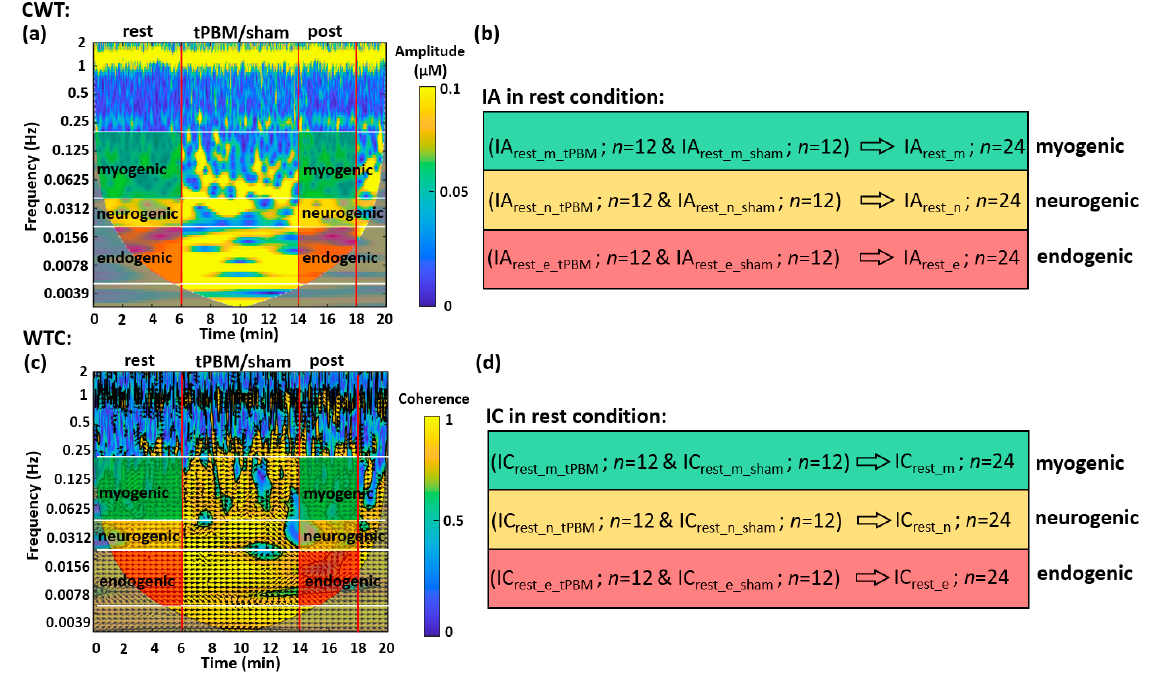
Figure 6. Example of CWT and WTC spectrograms presented in time-frequency maps and parame- terized indexes for the data taken at rest. ( a ) It plots a CWT spectrogram generated from the right forehead of one subject. The vertical red lines segment the experimental time into three periods: a 6-min resting period, an 8-min tPBM period, and a 4-min post-tPBM/sham period. The white hori- zontal lines mark three frequency bands: endogenic (0.005–0.02 Hz; red-shaded), neurogenic (0.02–0.04 Hz; yellow-shaded), and myogenic (0.04–0.2 Hz; green-shaded) bands. The colormap indicates the time-frequency dependent amplitude of wavelet transform of the Δ [HbO] time series. Two gray- shaded areas indicate the cone of influence (COI) caused by the edge effects of wavelets and ex- cluded for further data processing due to unreliability [84–86] . ( b ) It expresses the index of ampli- tude (IA) calculated by averaging CWT amplitude in the 2-dimensional, shaded areas given in ( a ) for respective ISO frequency bands. Subscripts of “rest_m_tPBM” and “rest_m_sham” mean under resting and sham conditions for tPBM experiment at myogenic frequency, respectively. The same notations apply to the other two situations. “ n = 12” indicates the subject number for each of tPBM and sham experiments. For both baseline measurements, the total measurement number becomes 24. ( c ) It plots a WTC spectrogram generated from the coherence between two bilateral Δ [HbO] time series of one subject. Both red vertical and white horizontal lines serve the same purposes as those in ( a ). The arrows indicate the phase relationships between the two time series. The colormap marks time-frequency-dependent coherence amplitude between two bilateral Δ [HbO] time series. The gray-shaded COI areas were excluded for further data analysis. ( d ) It expresses the index of coher- ence (IC) for each ISO frequency band calculated by averaging shaded areas given in ( c ) for respec- tive ISO frequency bands. While the red-, yellow-, and green-shaded areas in ( a ) and ( c ) are the regions of interest for calculations of IA and IC in three respective ISO frequency bands, they were separately quantified for the resting (or pre tPBM) and post-tPBM period.